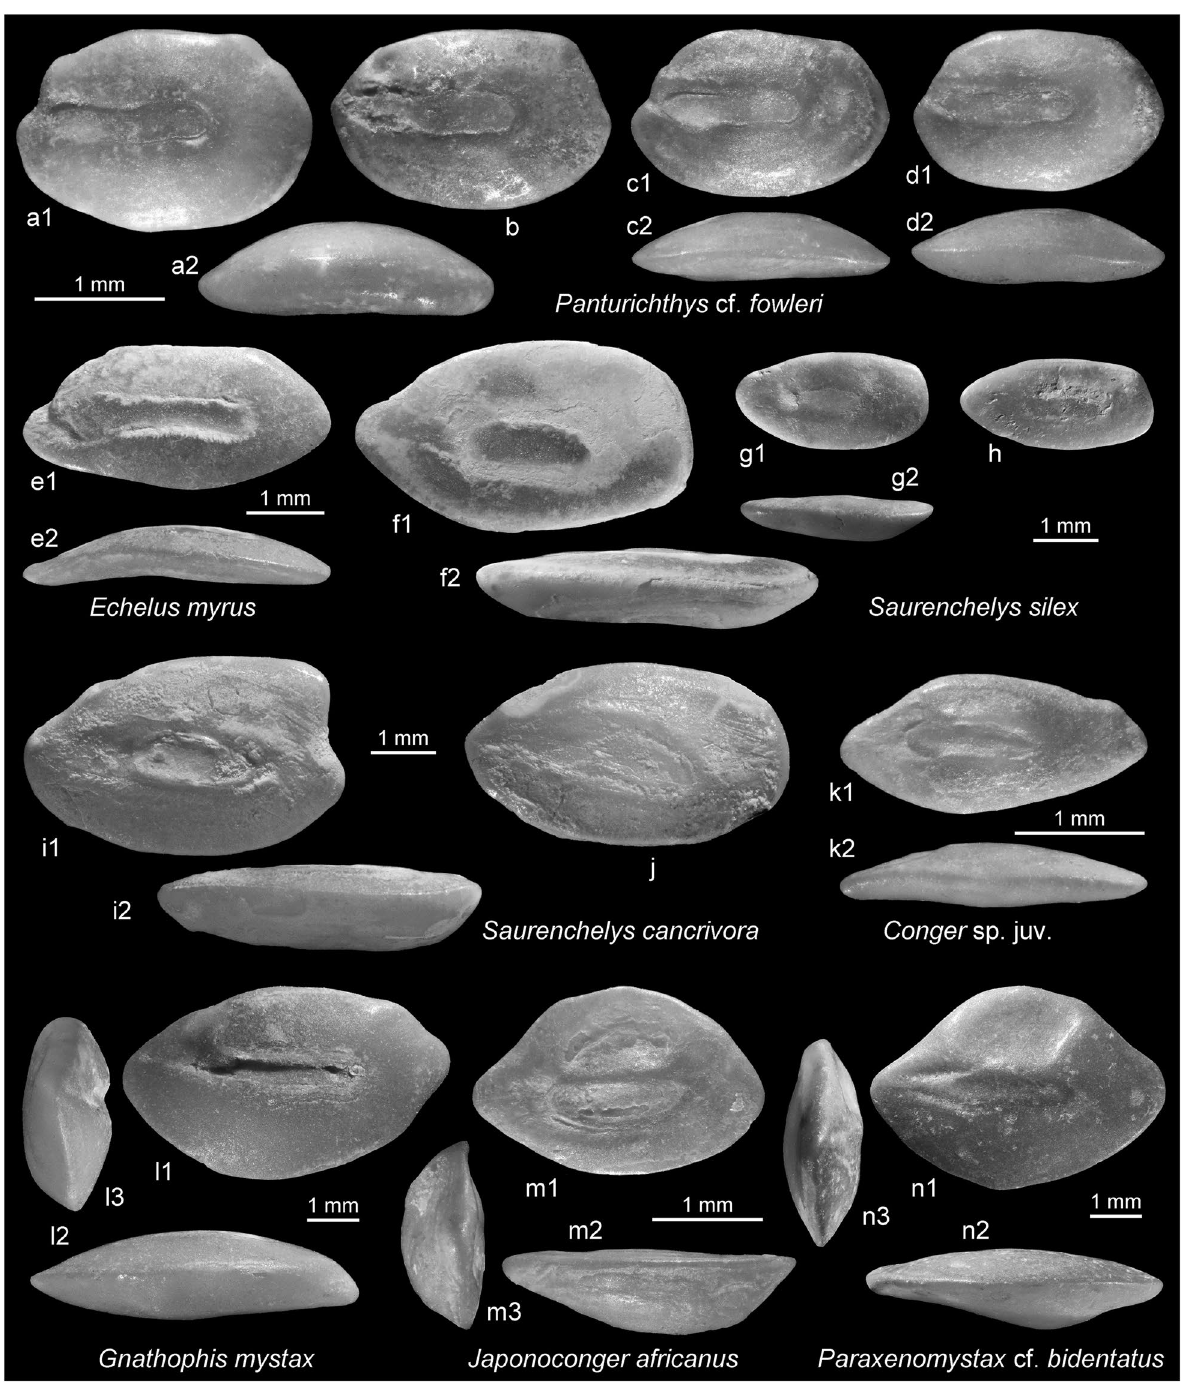
Fig. 10 Anguilliformes. a – d Panturichthys cf. fowleri (Ben-Tuvia, 1953), SMF PO 101.184 ( a reversed), Dar bel Hamri. 10 e , Echelus myrus (Linnaeus, 1758), SMF PO 101.216 (reversed), Dar bel Hamri. f – h , Saurenchelys silex van Hinsbergh & Hoedemakers, 2022, Dar bel Hamri, Zanclean, f SMF PO 101.186, g – h tentatively assigned specimens, SMF PO 101.815 (reversed). i – j , Saurenchelys cancrivora Peters, 1864, extant, West Pacific, i BSKU 69087, j BSKU 75296. k , Conger sp. juv., SMF PO 101.187 (reversed), Dar bel Hamri. l , Gnathophis mystax (Delaroche, 1809), SMF PO 101.188 (reversed), Dar bel Hamri. m , Japonoconger africanus (Poll, 1953), SMF PO 101.189 (reversed), Dar bel Hamri. n , Paraxenomystax cf. bidentatus Reid, 1940, SMF PO 101.273, Dar bel